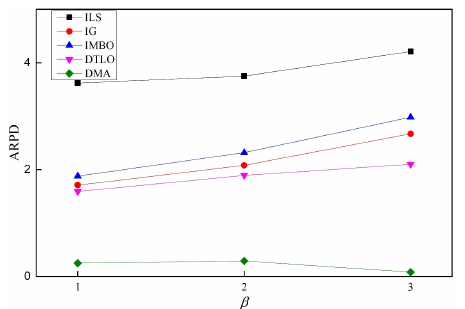
Figure 10. Performance comparison with different breakdown numbers.